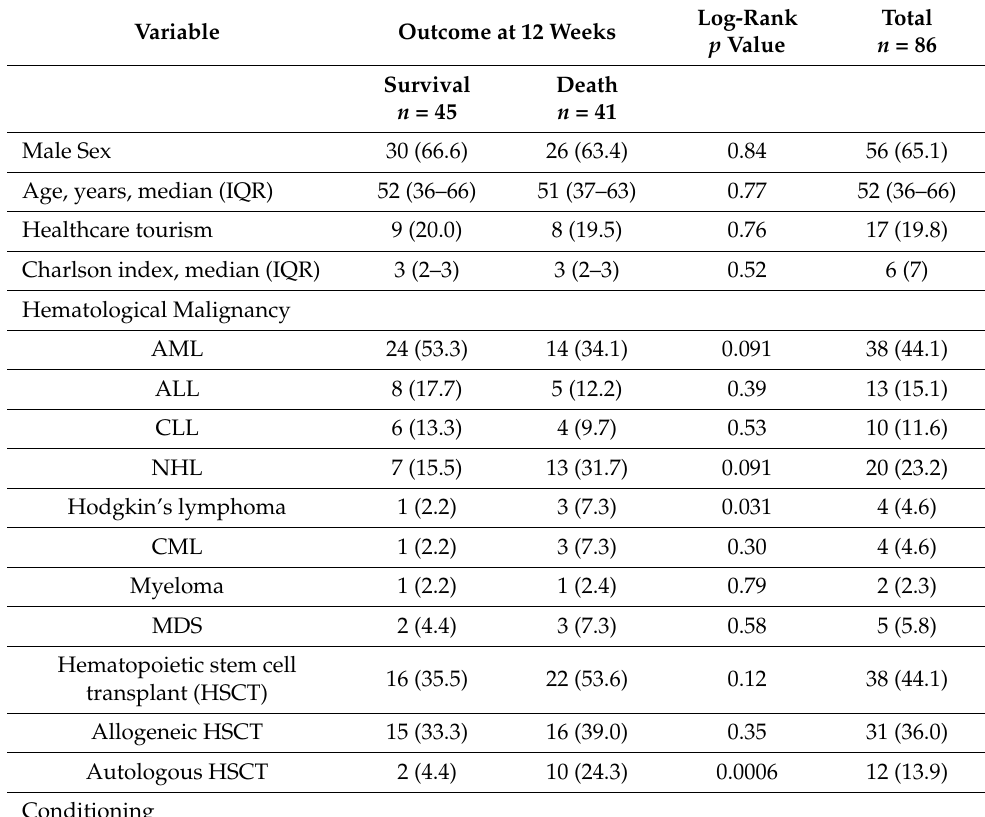
Table 1. Characteristics of patients according to 12-week survival